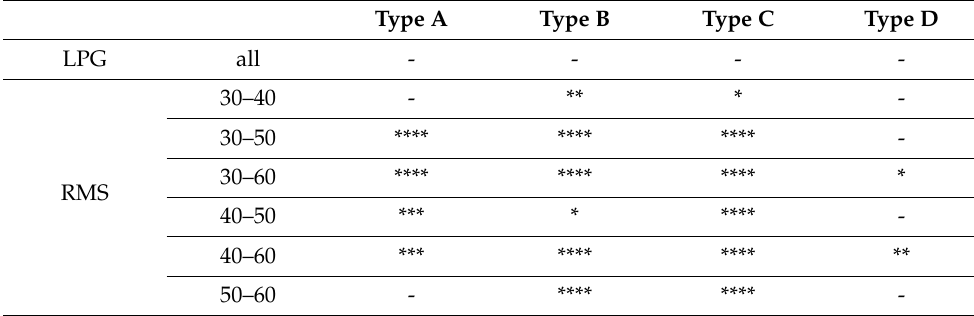
Table 5. TukeyHSD test results for the initial speed effect.